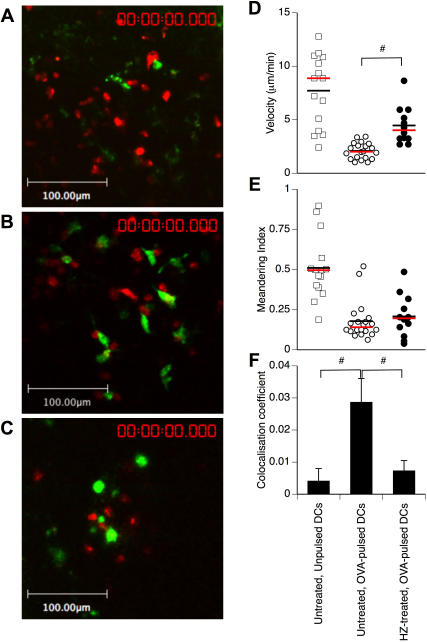
DC–T Cell Interactions Are Inhibited In Vivo by HZBALB/c mice were injected with CMTPX-labelled DO11.10 T cells (red) and CFSE-labelled DCs (green) which had been untreated (A), pulsed with OVA323–339 (B), or treated with HZ prior to OVA323–339 pulse (C). Cellular interactions in the draining popliteal LNs were imaged by multiphoton microscopy 24 h later. Images represent a z-compressed 30-μm stack from a single time point (full sequences available as Videos S6–S8). T cell migration was analysed using Volocity software (Improvision) and the mean velocity (D) and meandering index (E) of cells calculated. Mean and median values are represented by the red and black lines, respectively. DC–T cell interaction was measured by quantifying the colocalisation of green voxels with red to determine the proportion of DC volume in contact with T cells (F). Data shown are representative of three similar experiments (# p < 0.05).